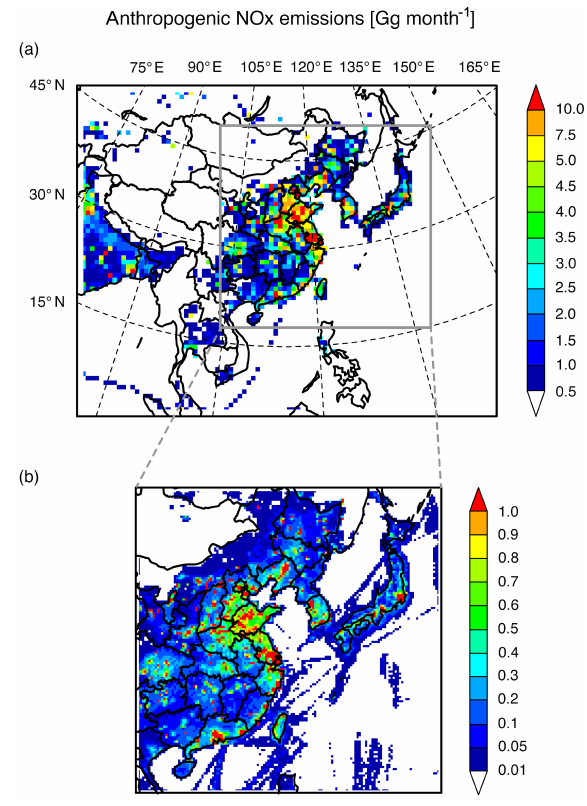
Figure 3. The modeling domain for the horizontal resolutions of (a) 81km and (b) 27km with anthropogenic NO x